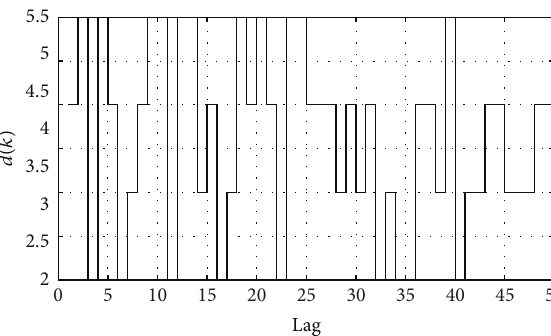
Figure 2: Time-varying delay 2 ≤ 𝑑(𝑘) ≤ 5 .